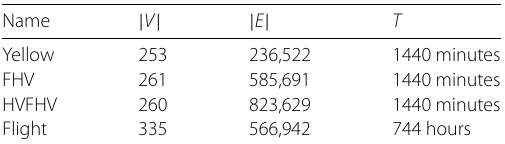
Table 3 Overview of the real-world networks used in the experiments. In each network, nodes represent the locations and edges represent the vehicle trips between pairs of locations. Each edge is associated with an interval for its period of activity